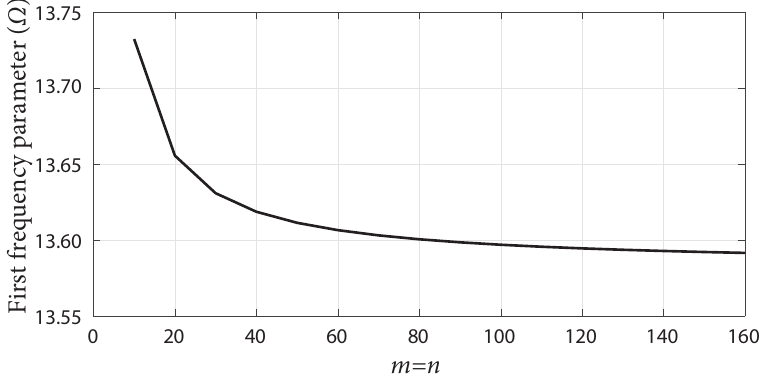
(cid:112) ρ h / D of a square isotropic